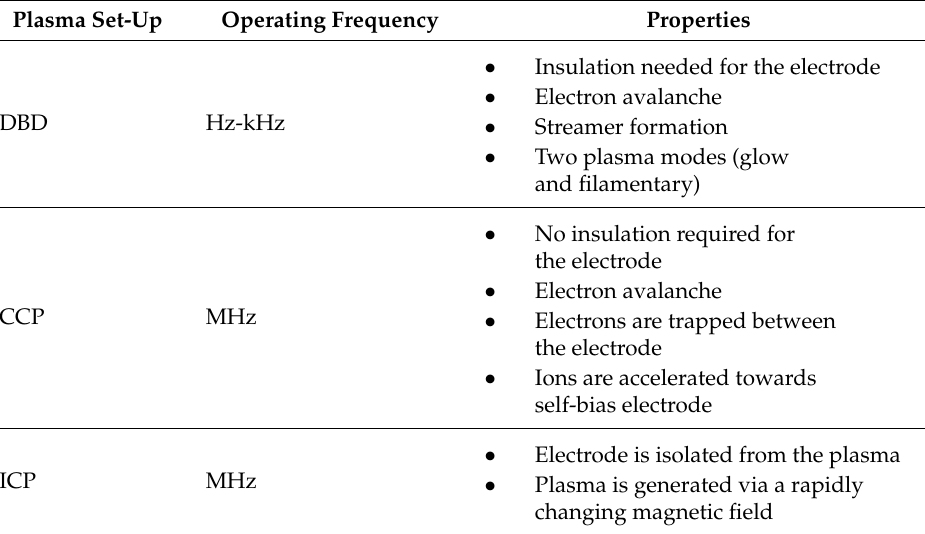
Table 6. Comparison of various plasma